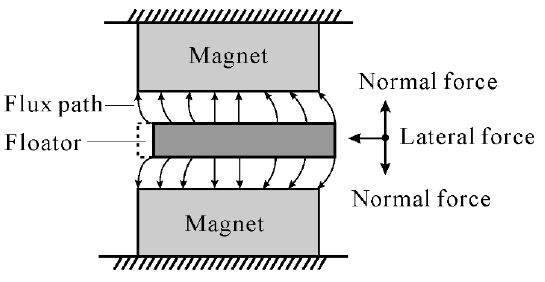
Figure 1. Concept of edge effect.